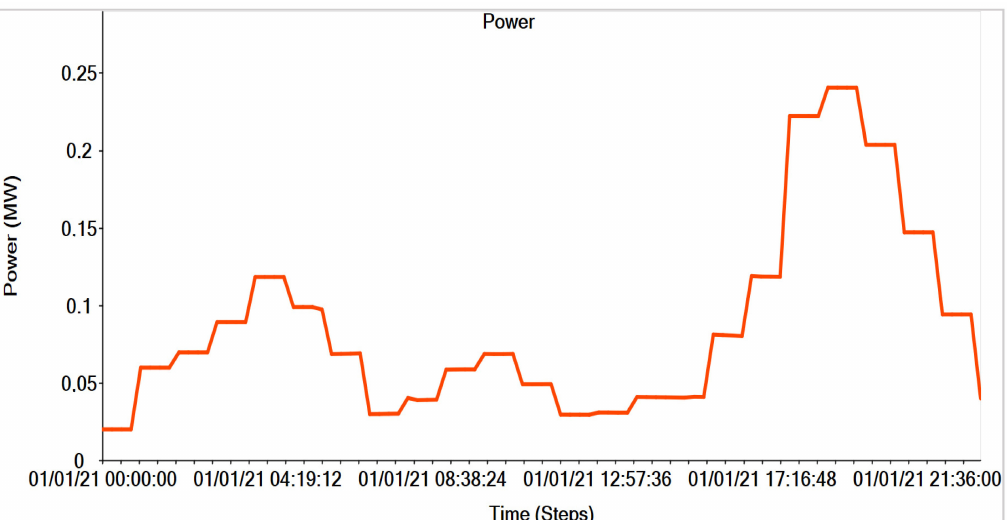
Figure 7. Daily load distribution